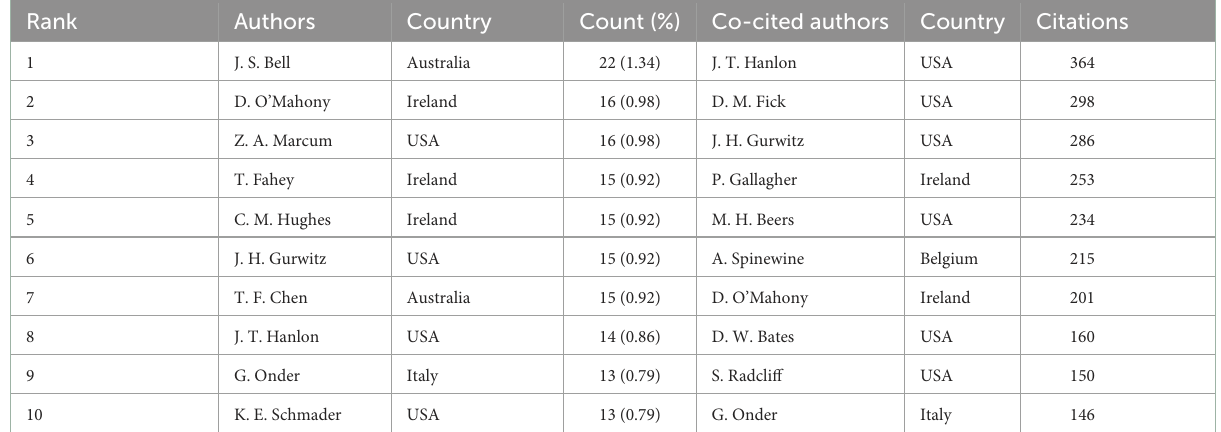
TABLE 3 Top 10 authors in terms of publications and co-cited authors in terms of citations from 2000 to 2021.